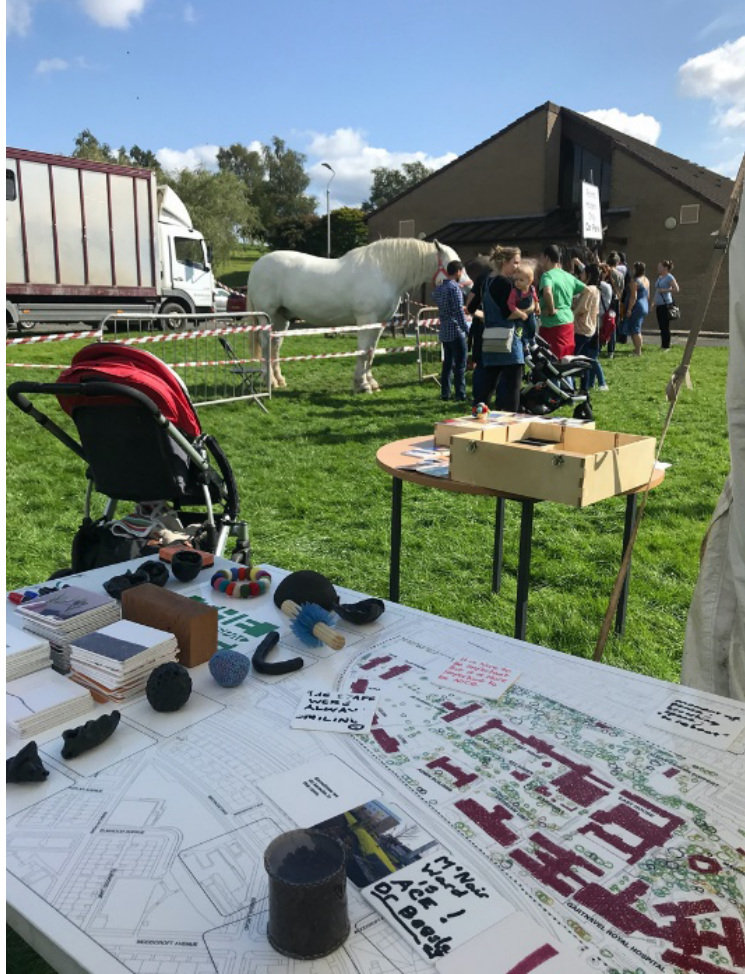
Figure 6. The annual festival Over the Wall at the hospital grounds in August 2018 with horses, theatre, music among other things. In the foreground our pop-up exhibition The Gart Game. Source: Ebba